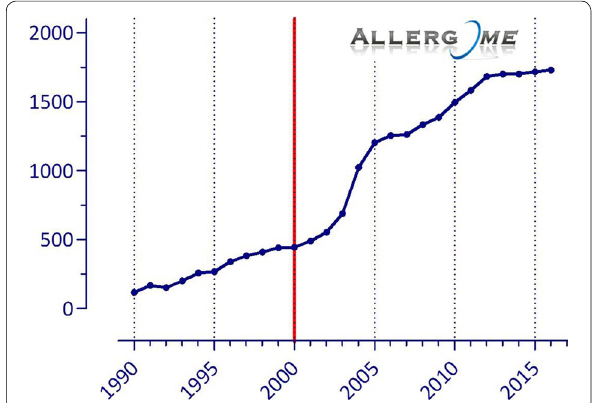
Fig. 2 Time trend of allergenic sources ( dashed line ) and molecule identification ( straight line ) in the last